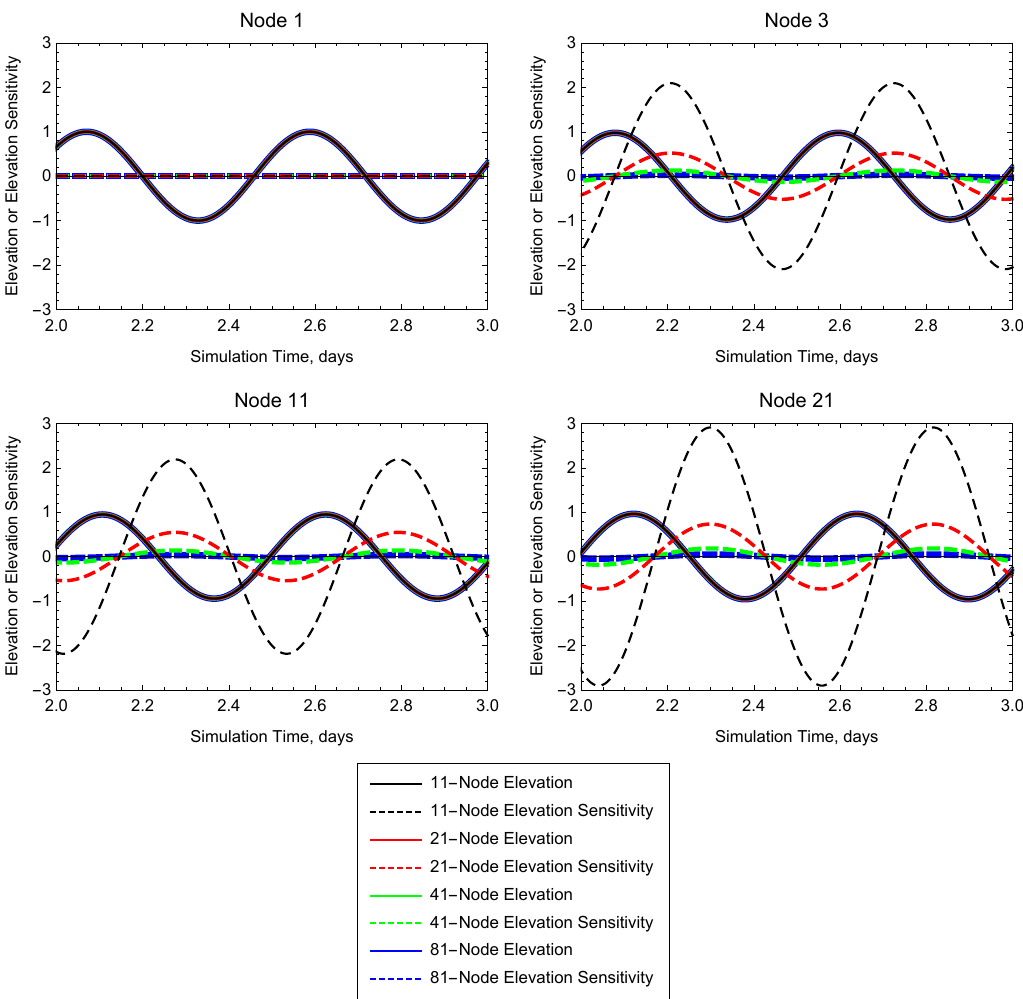
Figure 1. Elevation (m) and elevation sensitivity to G (ms) for different simulations on the linear sloping domain, with each simulation using a different resolution grid (11-node, black; 21-node, red; 41-node, green; and 81-node, blue). The solid lines depict the elevation results, while the dashed lines show the temporal evolution of the sensitivity of the elevation to G . The node number listed in the title for each panel is the node number in the 21-node grid associated with a given